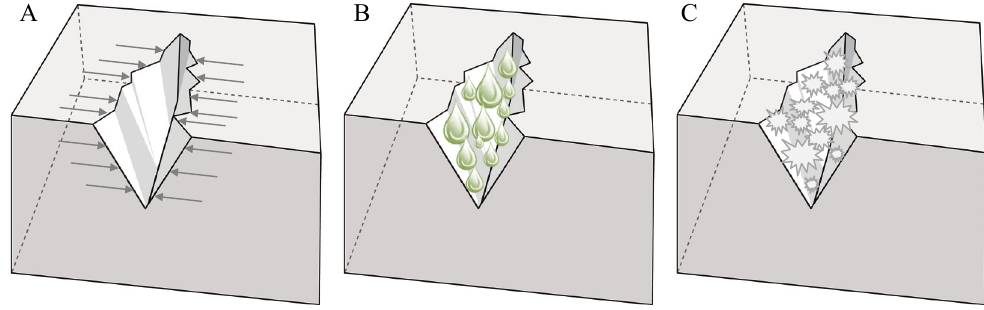
Figure 2. Intrinsic self-healing approaches. Improved autogenous healing by restriction of the crack width ( A ); water supply ( B ) or improved hydration and crystallization ( C